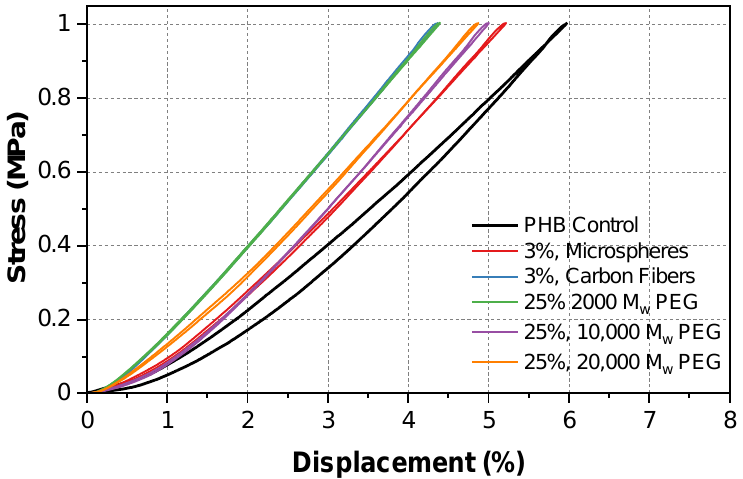
Figure 10. Stress/displacement diagram of PHB composites under 1 MPa compression for the analysis of maximum displacement.